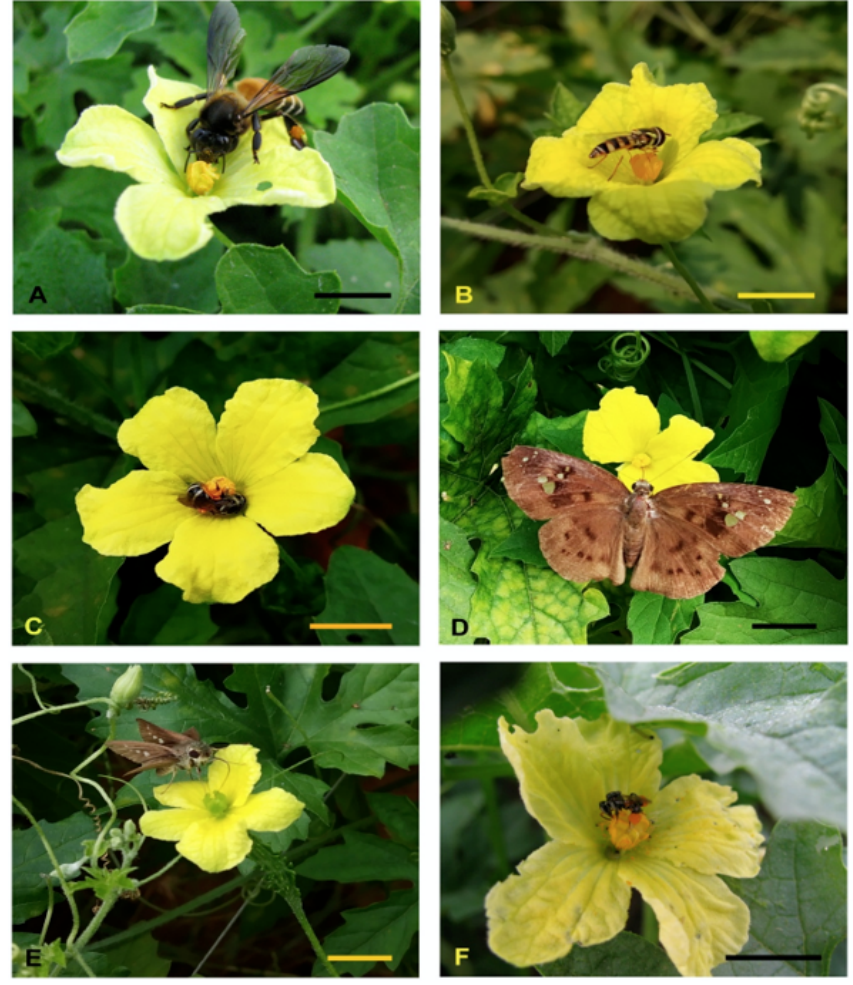
Figure 1 Floral visitors of Momordica charantia . ( A ) Apis dorsata , ( B ) Episyrphus balteatus , ( C ) Halictus sp., ( D ) Junonia iphita , ( E ) Pelopidas mathias , and ( F ) Tetragonula iridipennis . Scale bars = 10